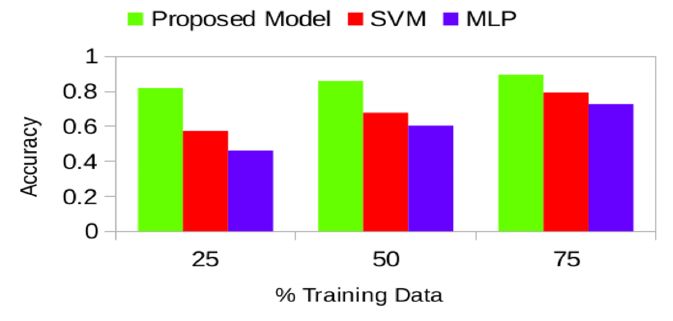
Figure 5. Overall prediction accuracy: proposed model vs. SVM vs.